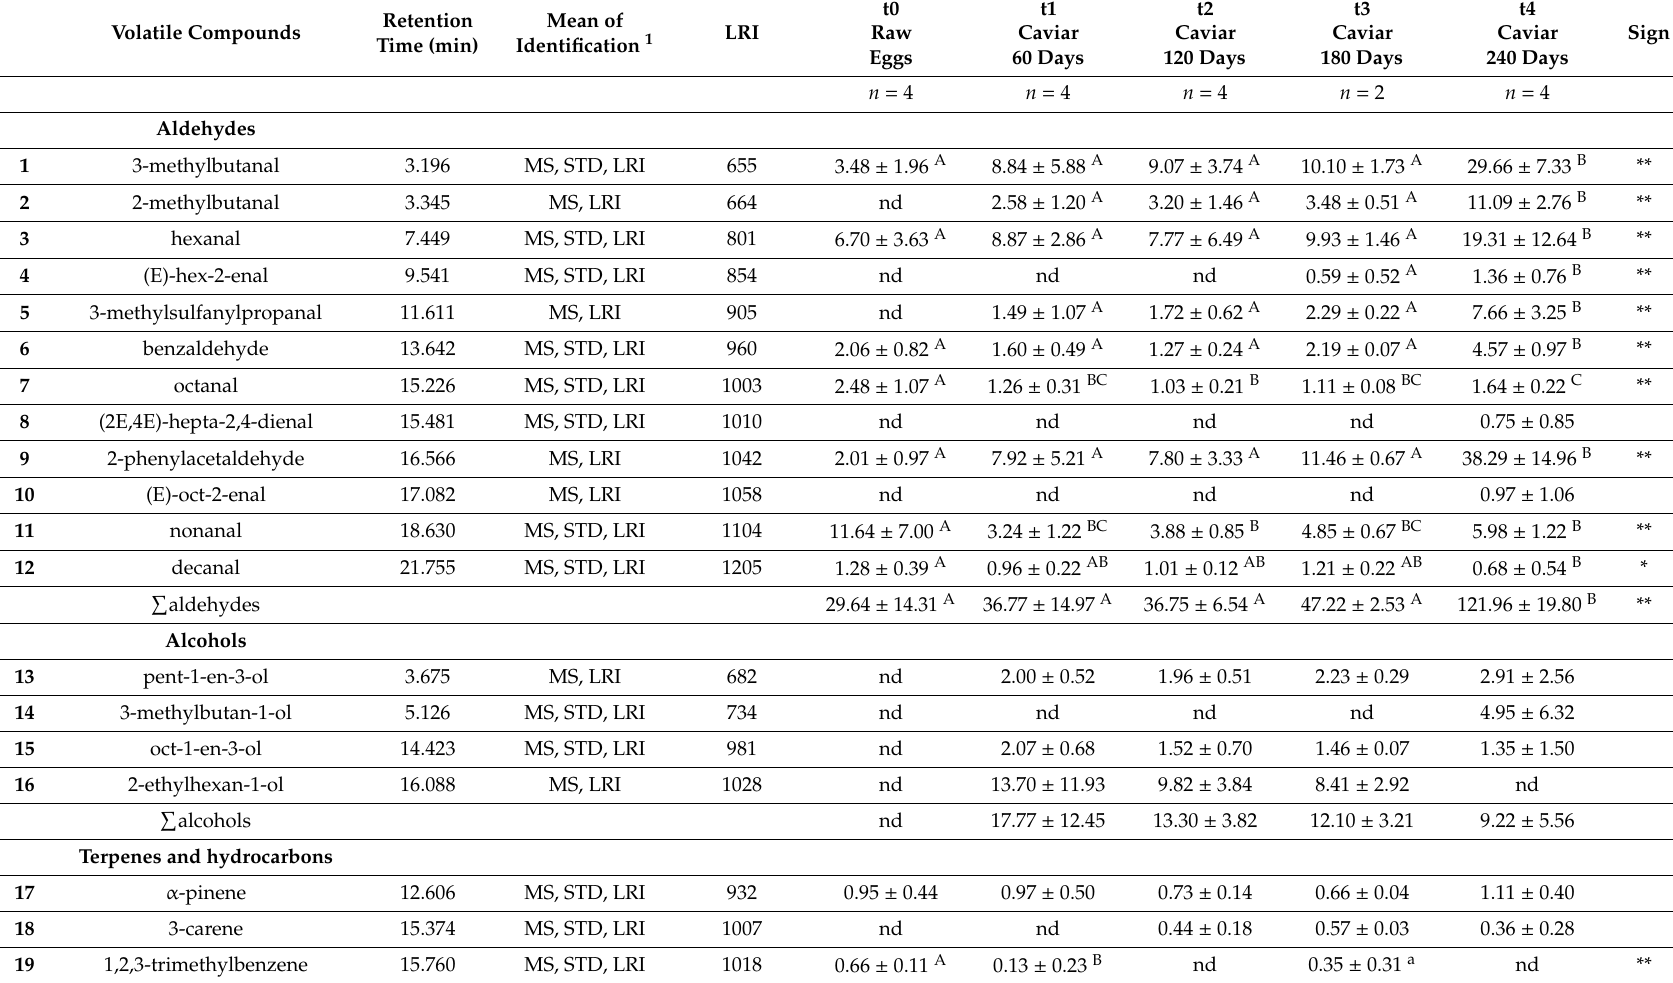
Table 2. Volatile compounds profile of caviar analysed by MHS-SPME-GC-MS